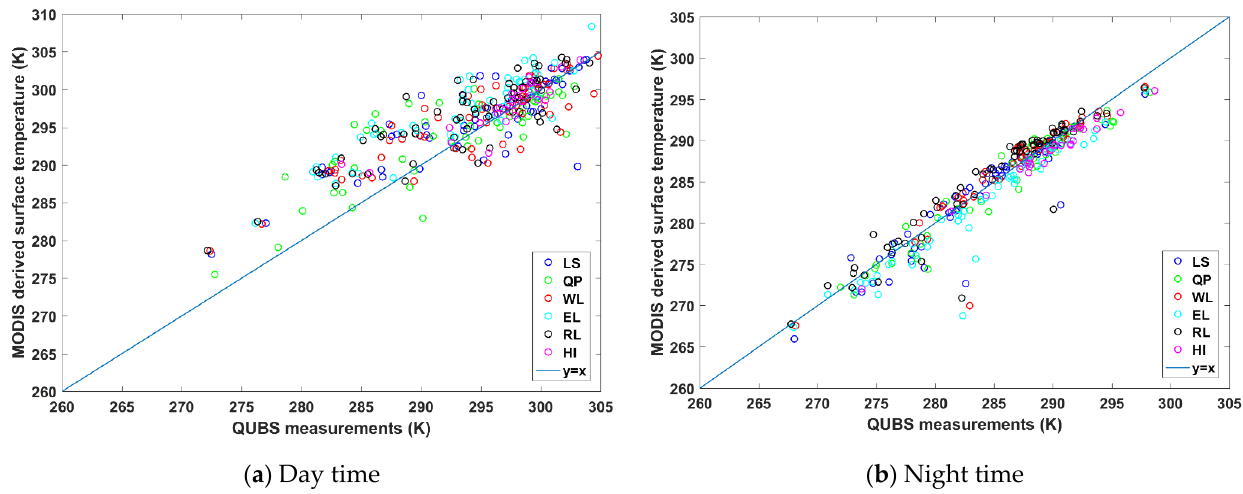
Figure 3. Scatter plots for temperature between MYD11A2 products and QUBS datasets for flooding seasons (March to September) of 2015 – 2017: ( a ) daytime; ( b ) nighttime. Table 2. MODIS LSWT statistics from different QUBS sites for flooding seasons of 2015 – 2017.